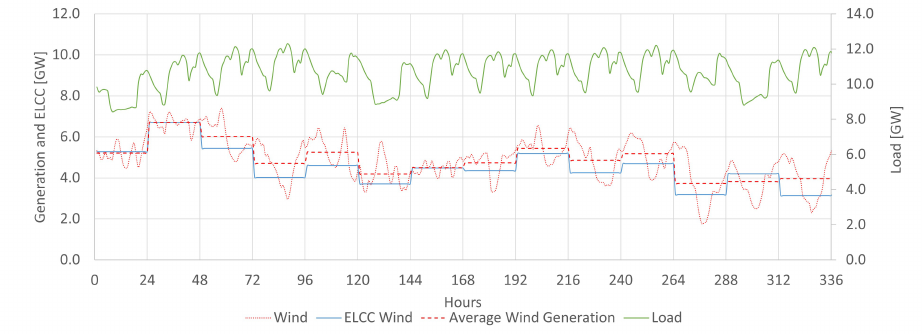
Figure 19. Load, wind generation, ELCC in an hourly basis for the first two weeks of 2019 for the Northeast